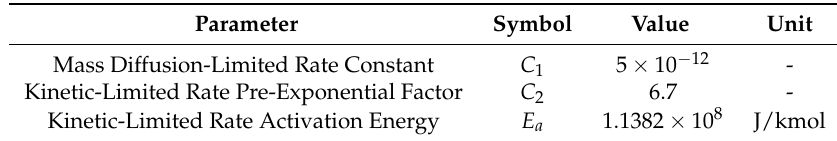
Table 6. Kinetic/diffusion-limited surface reaction rate model